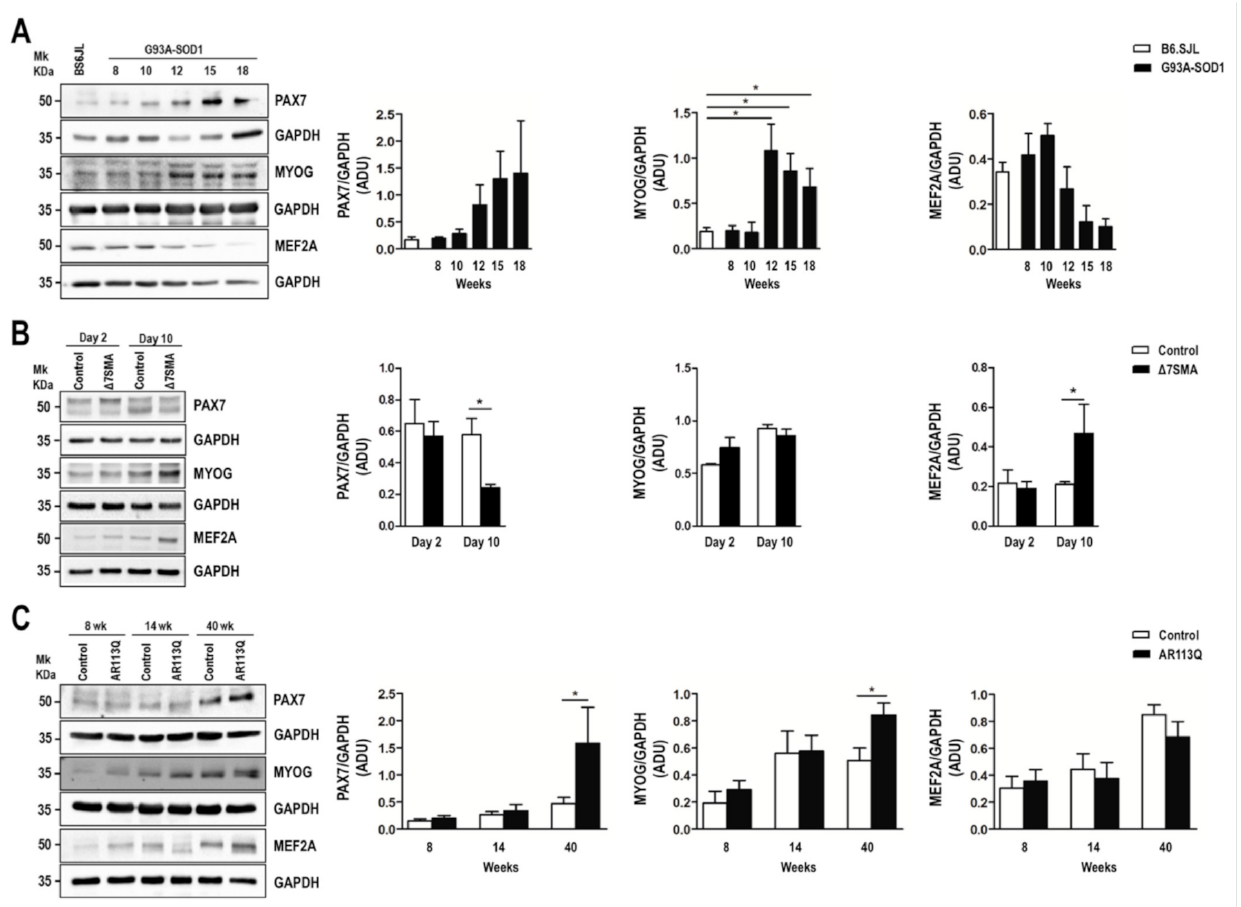
Figure 3. Altered expression of PAX7, MYOG, and MEF2A proteins in G93A-SOD1, ∆ 7SMA, and AR113Q mouse muscle as disease progresses. Representative western blot analysis of PAX7, MYOG, and MEF2A proteins in gastrocnemius muscle tissue of ( A ) G93A-SOD1 (black bars), ( B ) ∆ 7SMA (black bars), and ( C ) AR113Q (black bars) mice and control mice (white bars) ( n = 3 mice per group) with relative densitometric analysis. Density values are reported as mean ± SEM, corrected for background and normalized to GAPDH control. * p < 0.05, Mann-Whitney